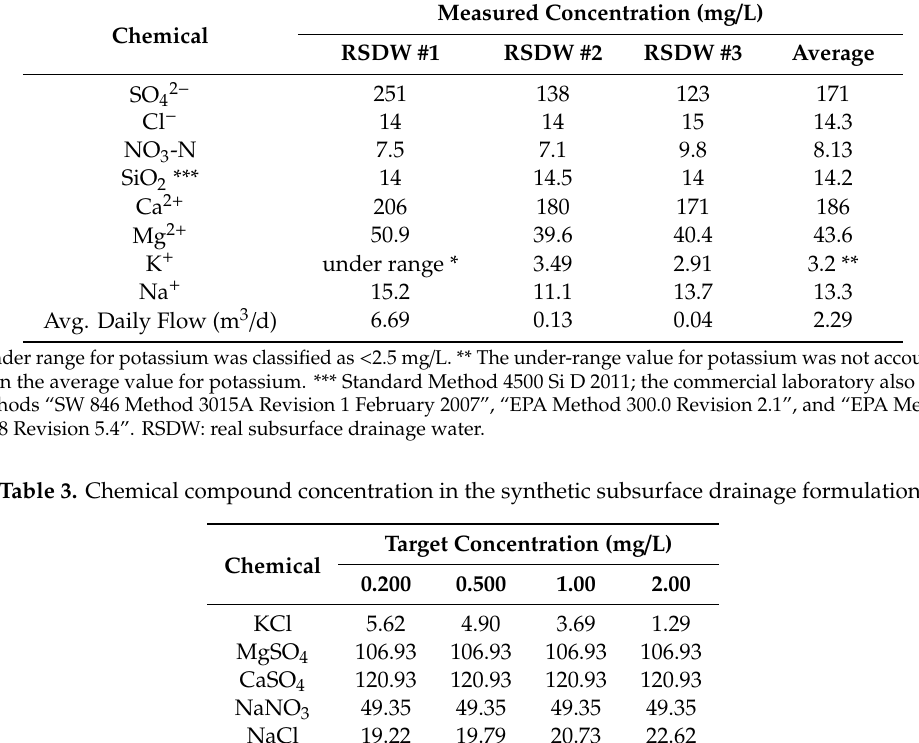
Table 2. Summary of ion analyses for three real subsurface drainage samples from the study site. Chemical